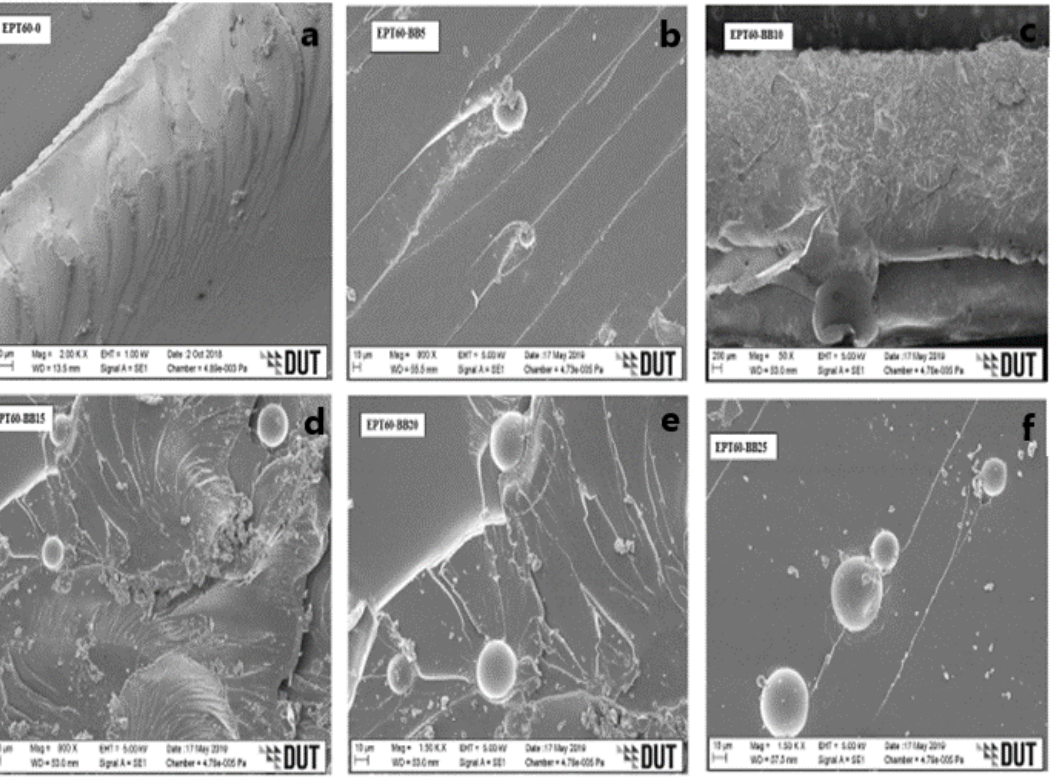
Figure 5. SEM images for flexural fractured specimens of SFC-homogenous HGM at ( a ) EPT60-0,